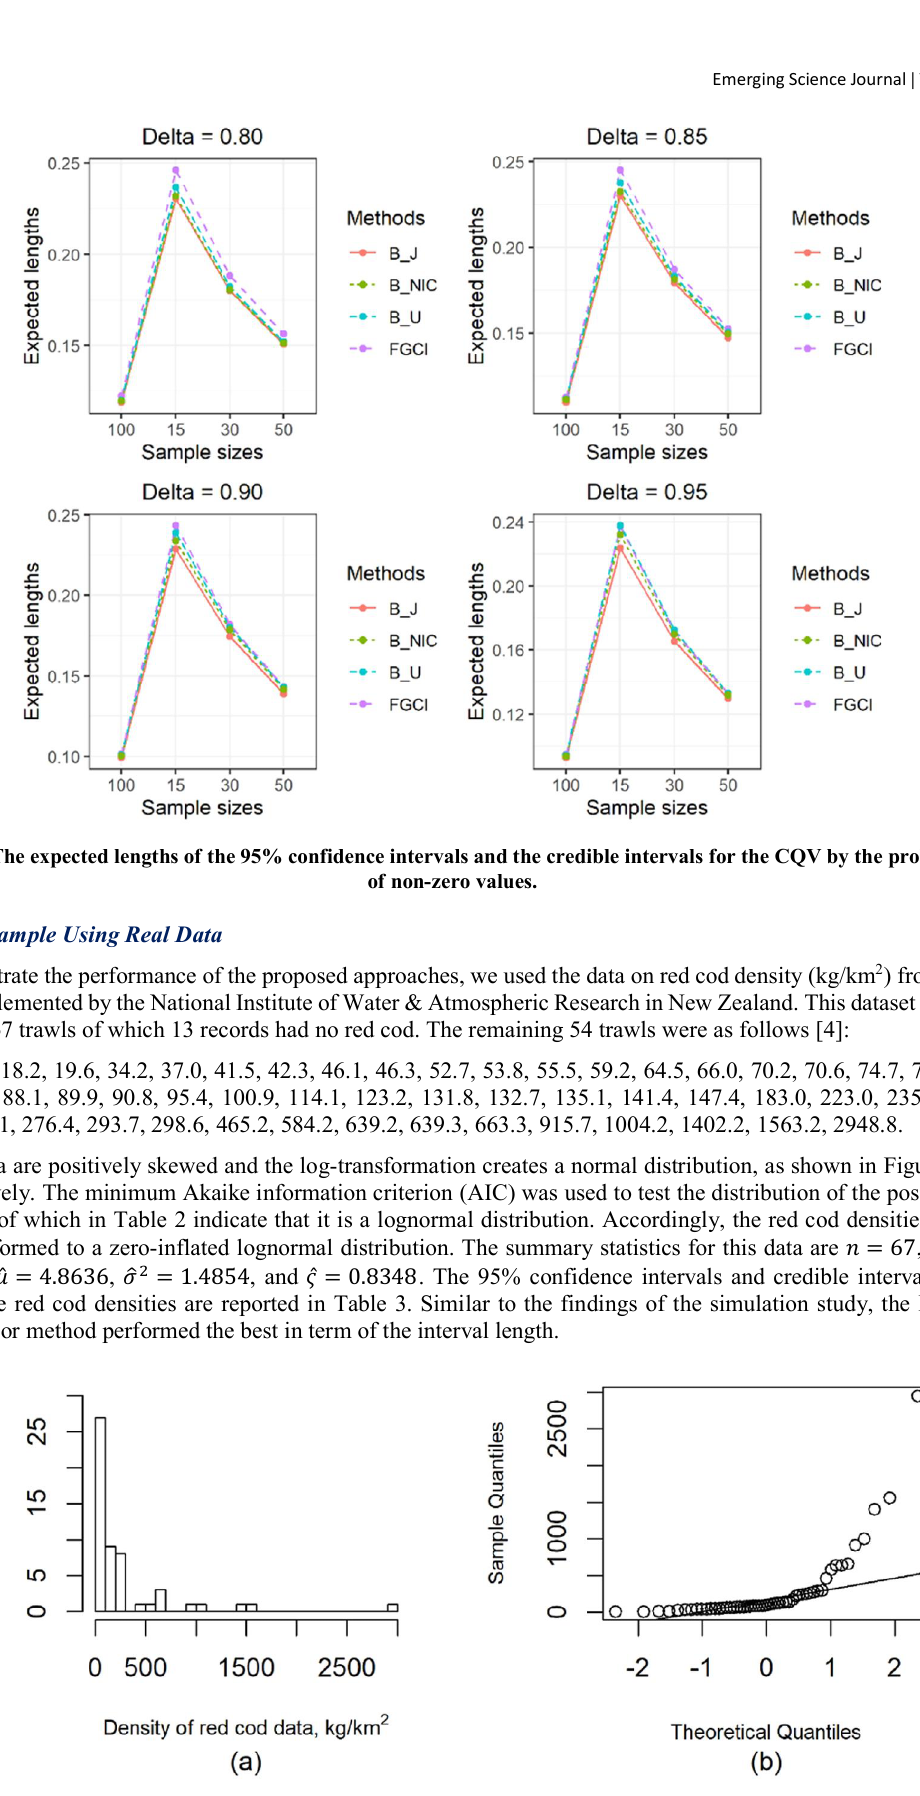
Figure 4. Distribution of the red cod data (a) a histogram (b) a normal Q-Q